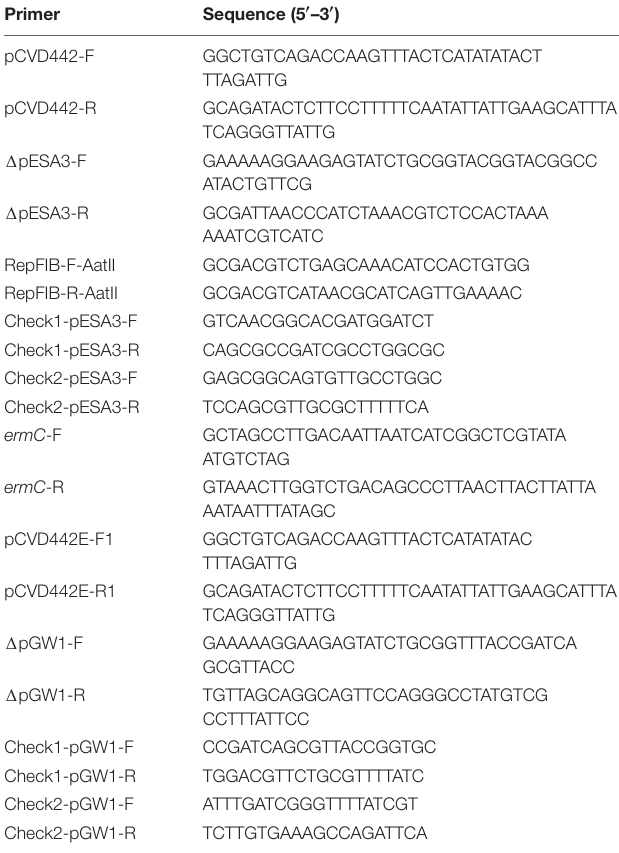
TABLE 3 | Primers used in this